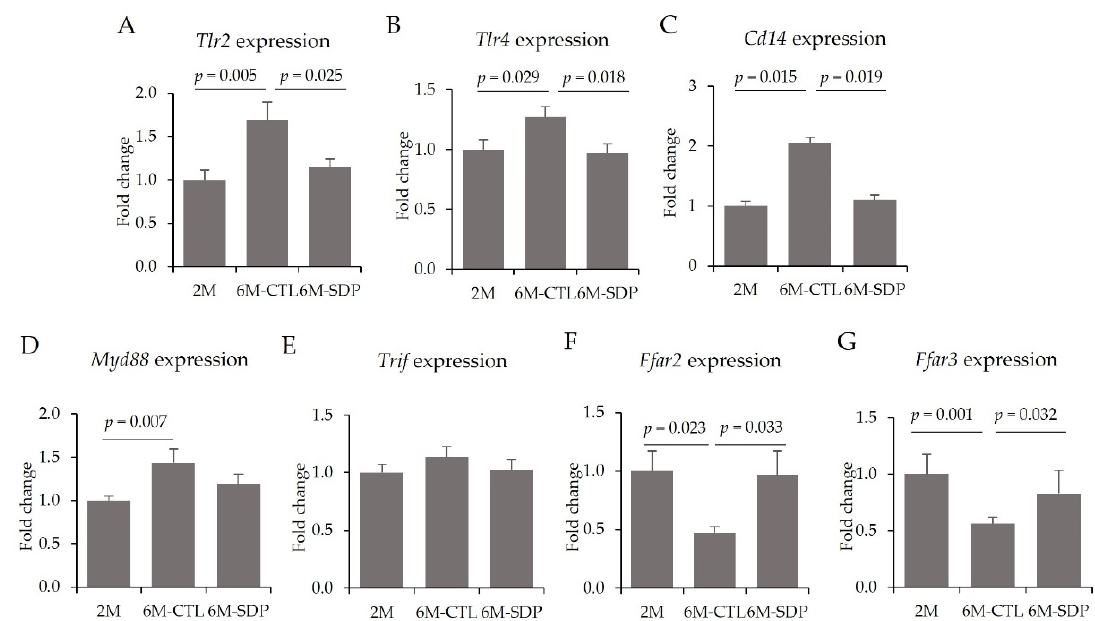
Figure 11. Gene expression of the TLR signaling pathway and SCFA receptors in colon mucosa. Tlr2 ( A ), Tlr4 ( B ), Cd14 ( C ), Myd88 ( D ), Trif ( E ), Ffar2 ( F ), and Ffar3 ( G ). Results are expressed as mean ± SEM ( n = 9–11 mice/group). Statistics: ANOVA (Fisher multiple comparison test). Cd14, cluster of differentiation 14; Ffar2, free fatty acid receptor 2 (GPR43); Ffar3, free fatty acid receptor 3 (GPR41); Myd88, myeloid differentiation factor 88; Tlr, toll-like receptor; Trif, toll-like receptor adaptor molecule 1.